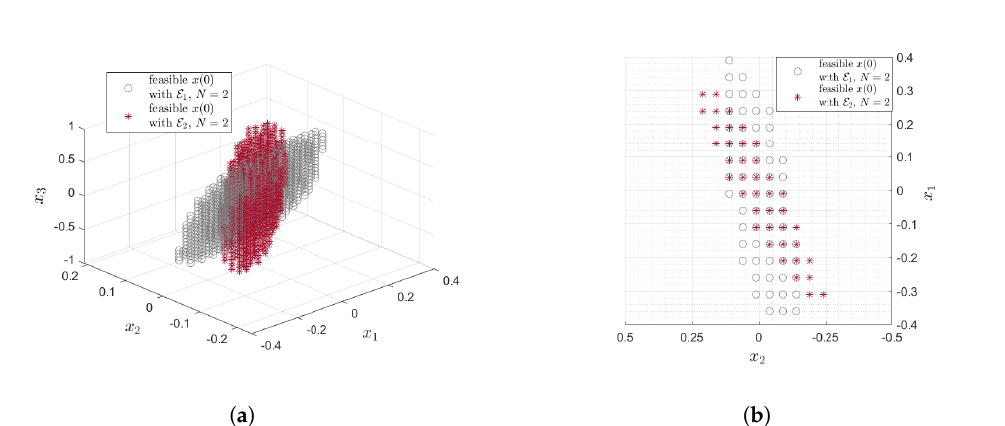
Figure 8. Few feasible initial states obtained using E i , i = 1,2 as the terminal set of a nonlinear MPC with N = 2, where they are is plotted ( a ) in a three-dimensional space and ( b ) in view of x 1 and x 2 axes. Note that some states are feasible only for the MPC with E i , i ∈ { 1,2 } .